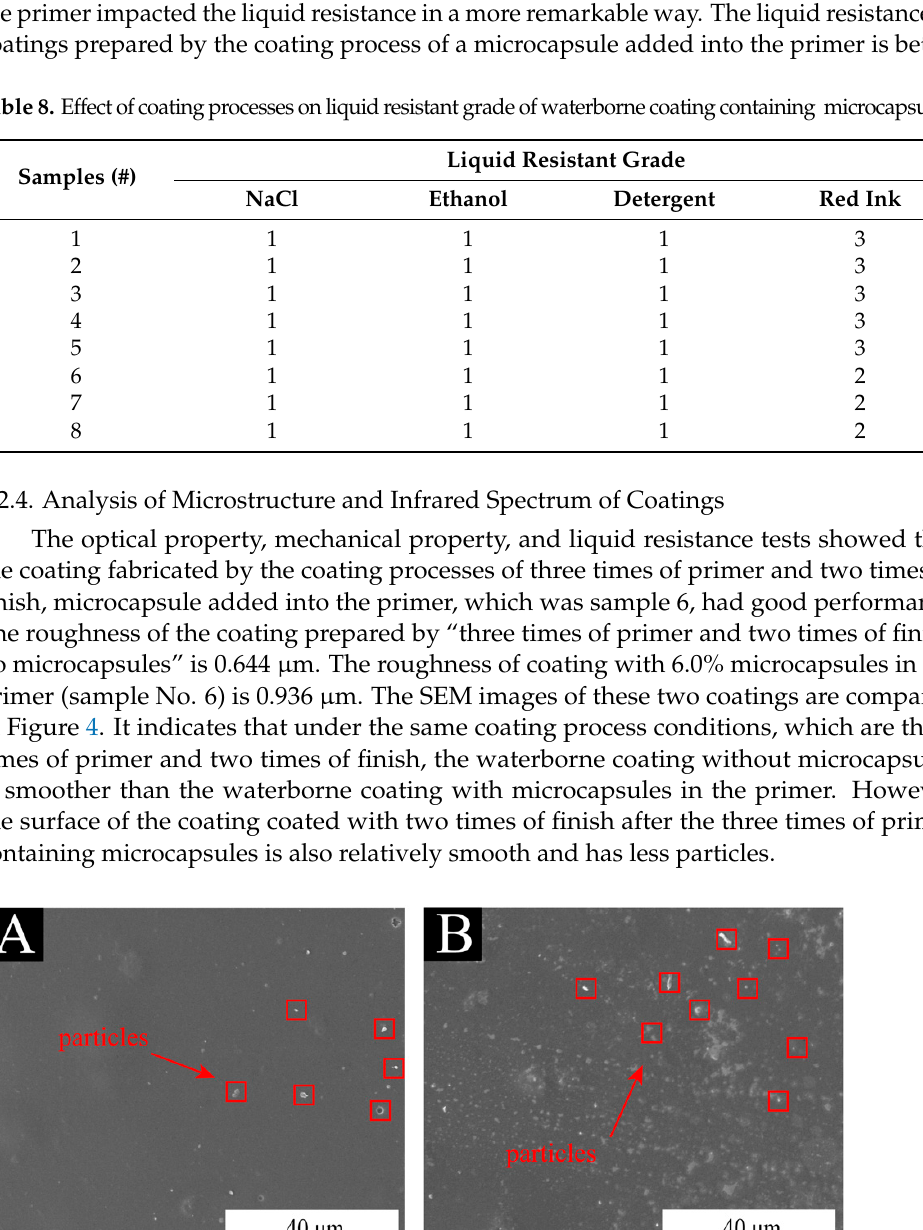
Figure 5. Infrared spectrum of paint film on three times of primer and two times of finish. 3.3. Aging Resistance Test of Waterborne Coating with Shellac Microcapsule Coated with Melamine/Rice Husk Powder From the above results, when shellac microcapsules coated with melamine/rice husk powder are mixed to the waterborne paint primer, the coating process of “three times of primer and two times of finish, microcapsule added into the primer” is better. The aging resistance test results of waterborne coatings without microcapsules and that with 6.0% microcapsule were analyzed. As shown in Figure 6, when the aging time was 8 h–40 h in the oven at 120 °C, the chromatic aberration of the coating with 6.0% microcapsule in- creased from 2.77 to 2.94, and that of the coating without microcapsule increased from 3.18 to 5.06. As shown in Figure 7, the chromatic aberration of the coating with 6.0% mi- crocapsules increased from 19.70 to 30.51, and that of the coating without microcapsules increased from 24.06 to 40.07 when the aging time was 8 h–40 h in the oven at 160 °C. As shown in Figure 8, with the aging time in the UV climate resistance test chamber increased